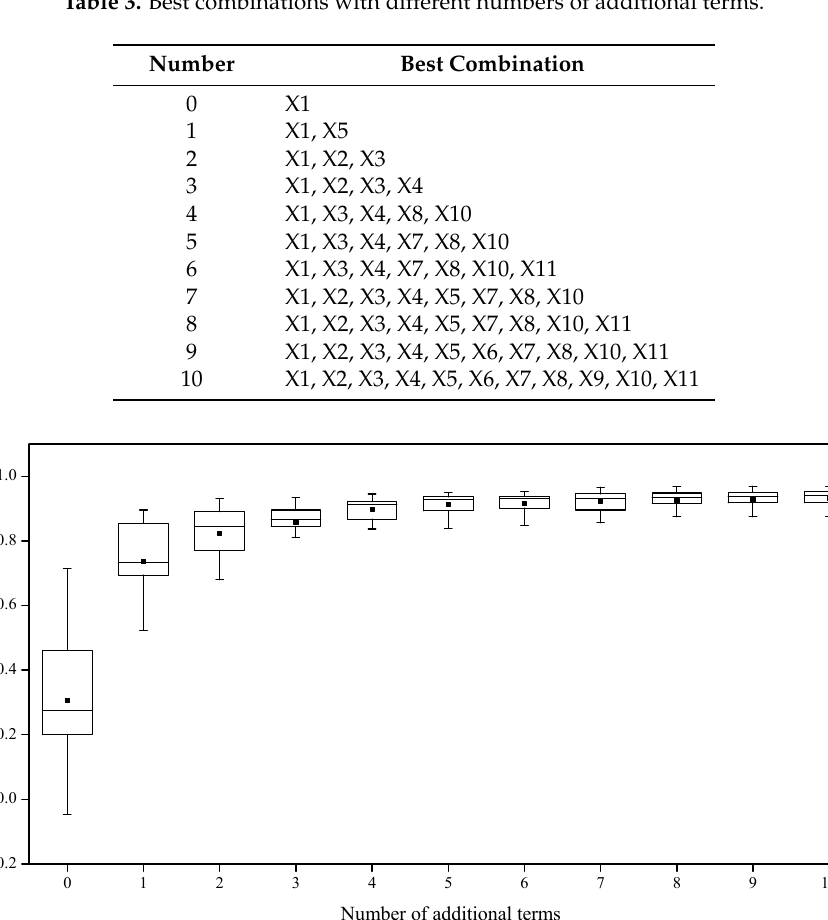
Table 3. Best combinations with different numbers of additional terms.